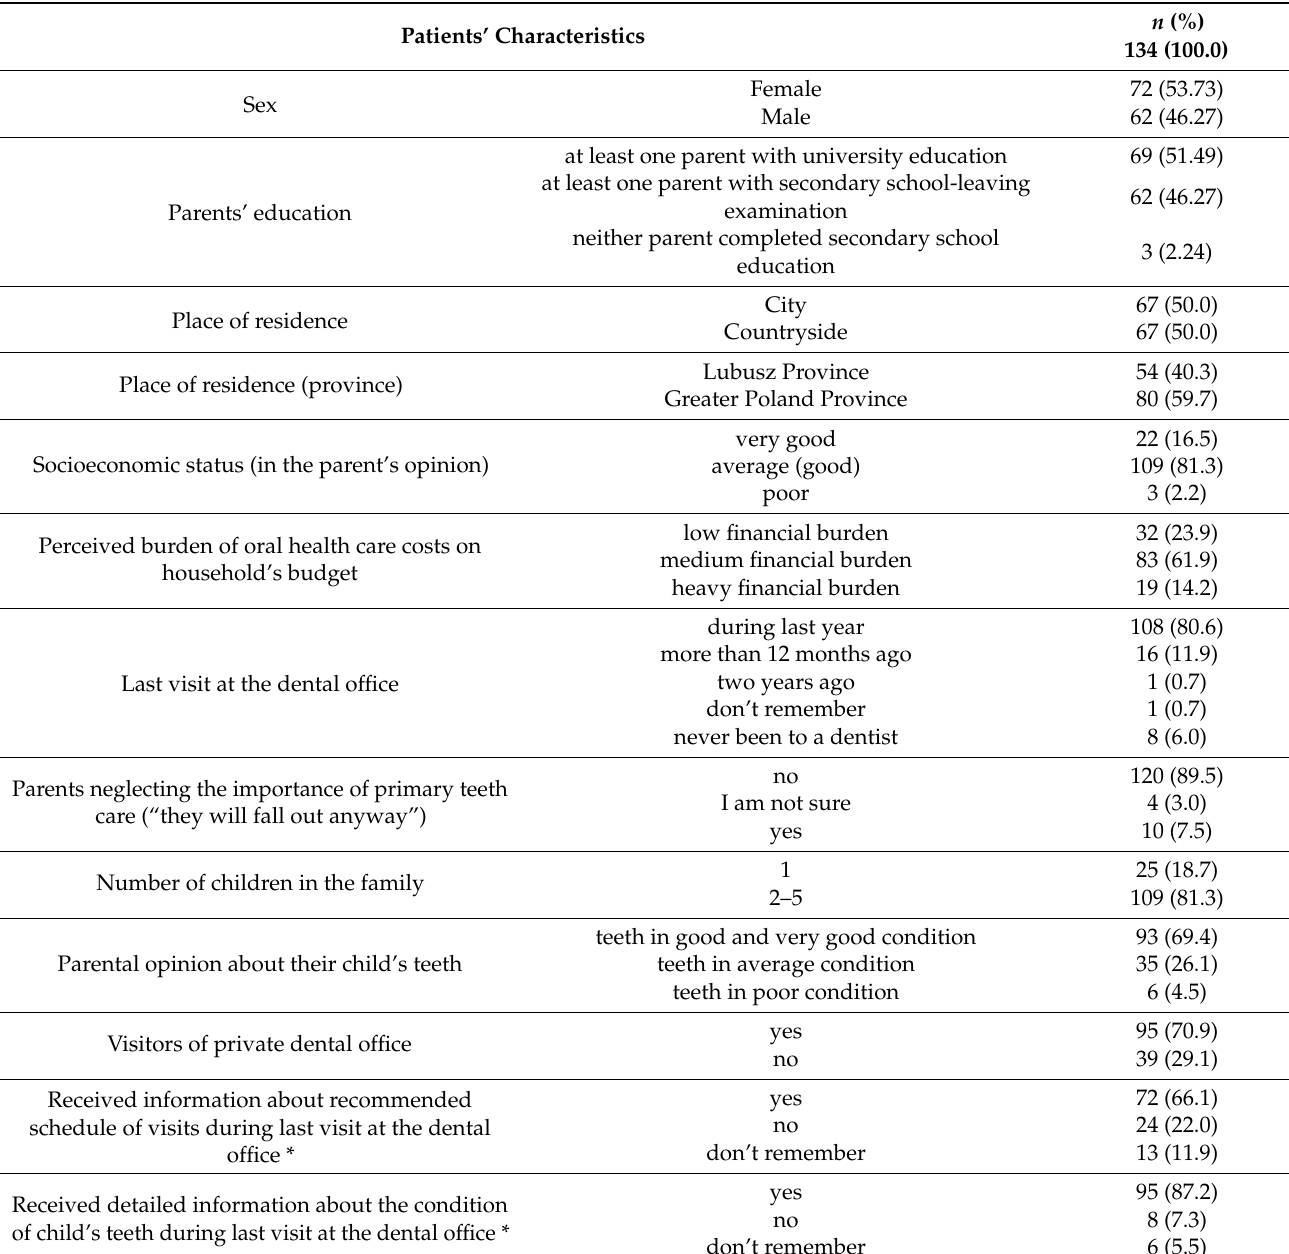
Table 2. Demographics of the study group and results of the questionnaire